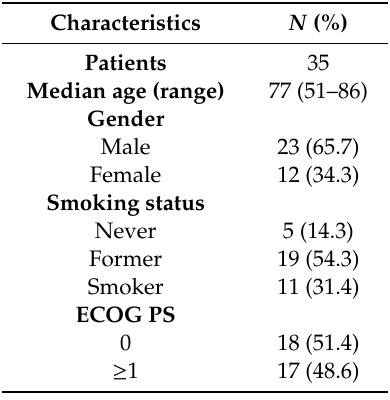
Table 3. Patients’ characteristics at